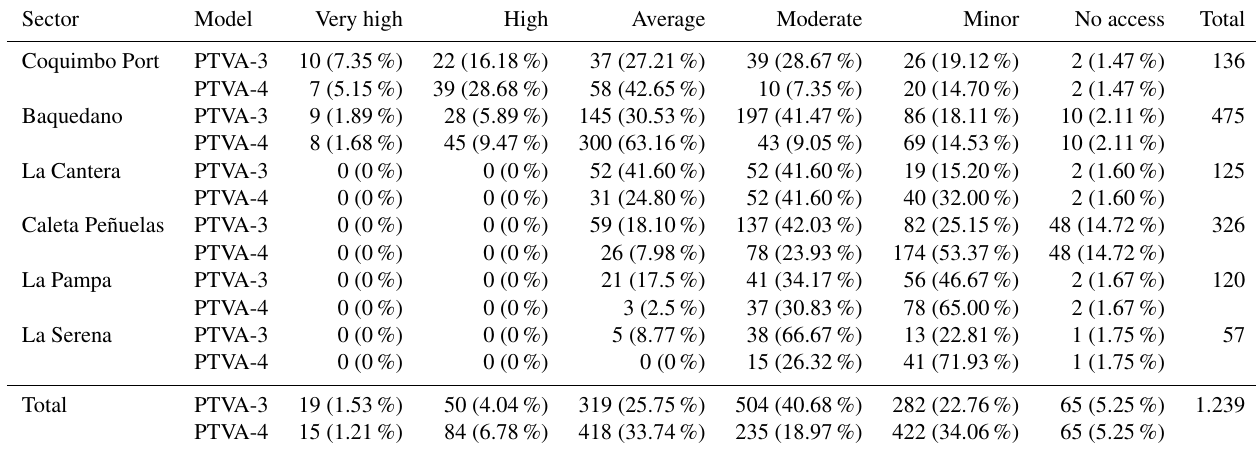
Table 6. Number of analyzed polygon in each sector and the obtained RVI score for PTVA-3 and PTVA-4 models. Sector Model Very high High